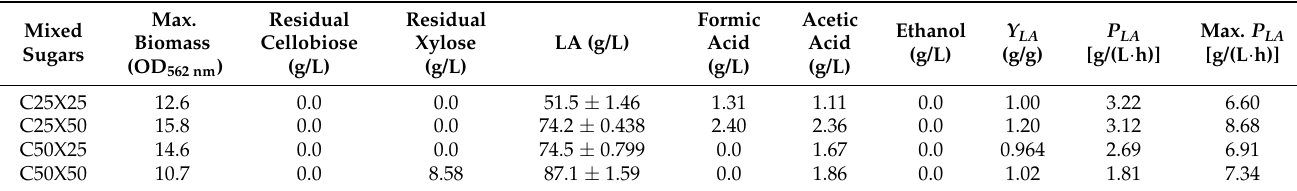
Strain Azu-10 achieved better fermentation efficiency with cellobiose/xylosemixture than glucose/xylose mixture in terms of sugar co-utilization, high LA titre, and yields. Table 4. Effect of different ratios of cellobiose/xylose mixtures on sugar utilization and lactic acid fermentation efficiency by B. coagulans Azu-10.